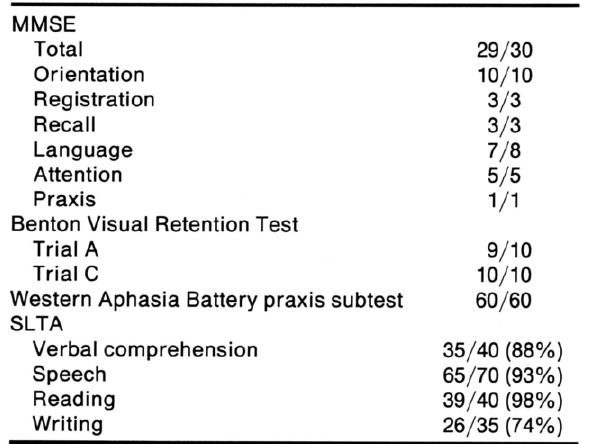
TABLE I. Results of neuropsychological examination MMSE